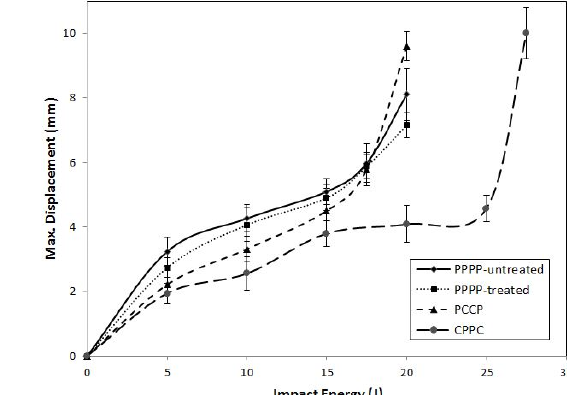
Figure 8. Maximum contact force and displacement against impact energy of the hybrid laminates at a ply orientation of [±45°] n .